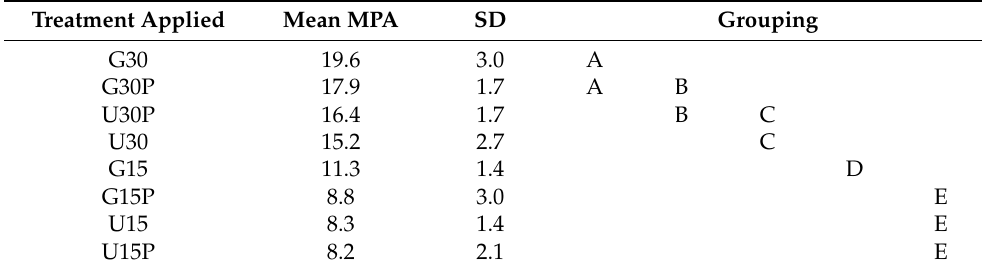
Table 2. Micro-shear bond-strength values, standard deviation, and groupings of the different samples. Treatment Applied Mean MPA